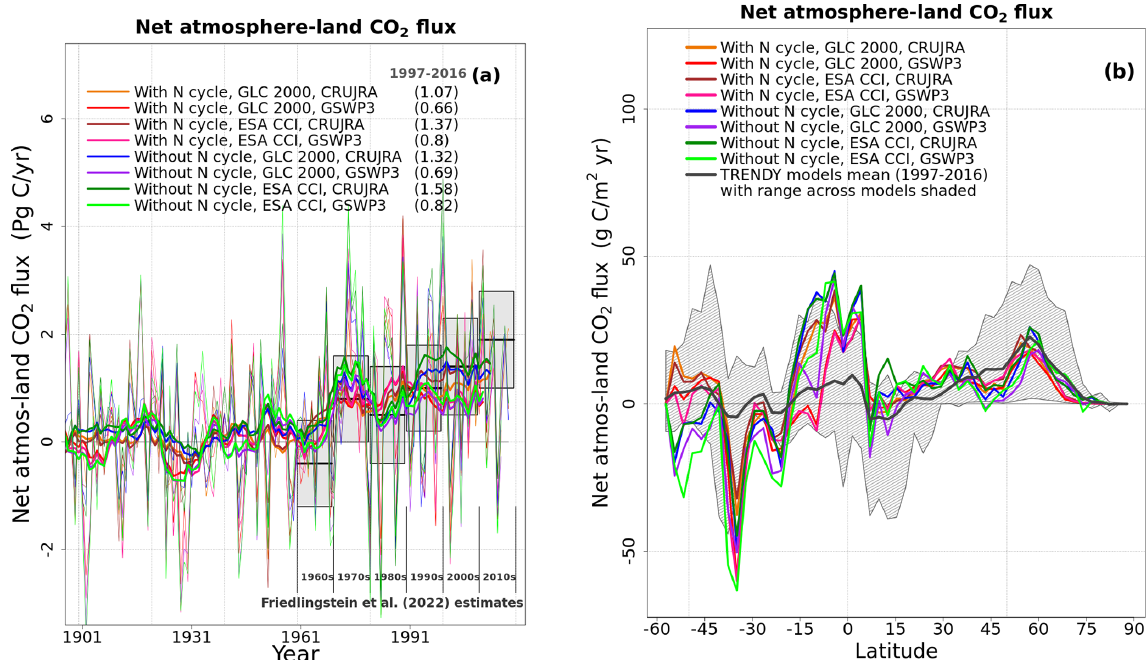
Figure A11. Time series of simulated global annual net atmosphere–land CO 2 flux (a) and its zonally averaged values from the eight simulations summarized in Table 1 averaged over the 1997–2016 period. In (a) simulated annual net atmosphere–land CO 2 flux values are compared to the estimates from the Global Carbon Project (Friedlingstein et al., 2022). The thin lines for the time series in (a) show the individual years, and the thick lines show their 11-year moving average. In (b) the simulated zonally averaged values are compared to the range from 11 models that contributed to the TRENDY 2020 intercomparison and are averaged over the 1997–2016